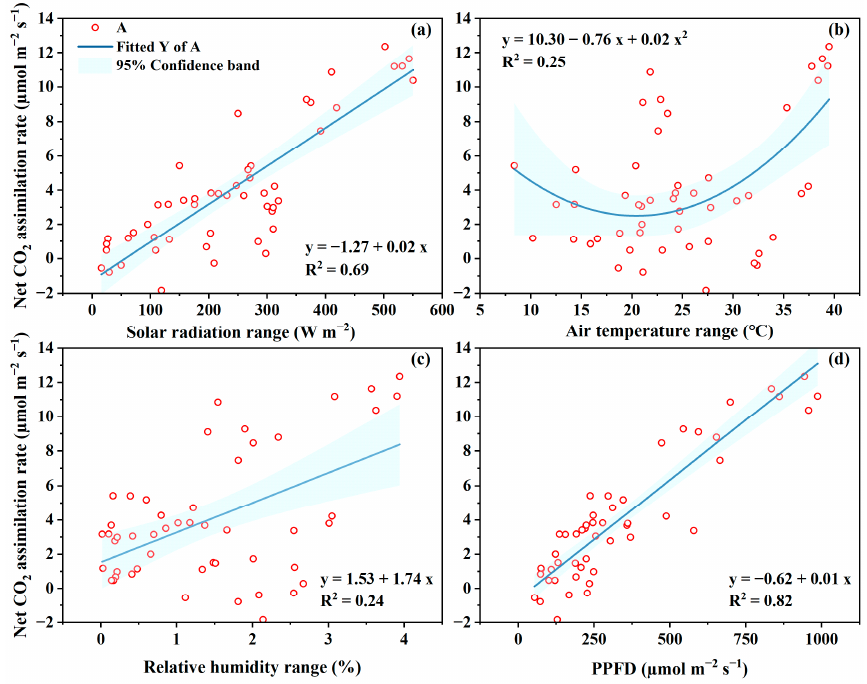
Figure 6. The relationships between photosynthesis rate to solar radiation ( a ), air temperature ( b ), vapor pressure deficit ( c ) and the photosynthetic photon flux density (PPFD) reaching to leaf ( d